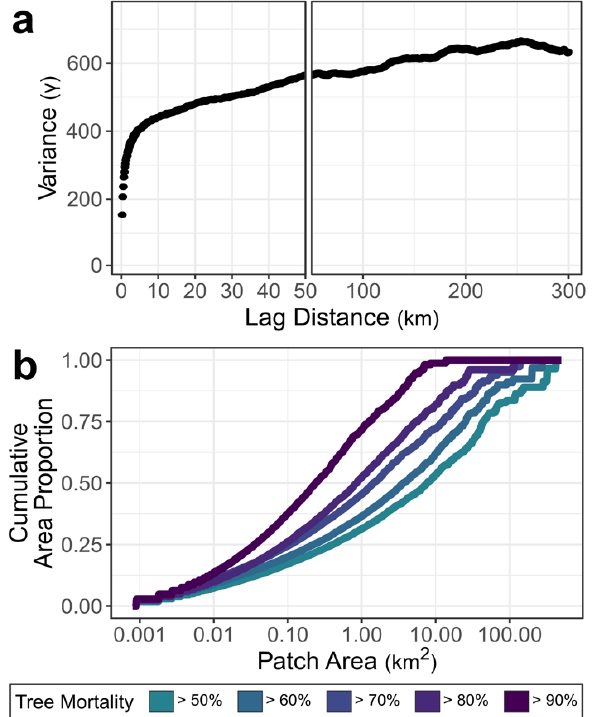
Figure 5. Spatial patterns of bark beetle-caused tree mortality in the Southern Rocky Mountains, USA. ( a ) Sample variogram shows the relationship of tree mortality (i.e., percent basal area loss) among sites at distances from 0 to 300 km, where higher values on the y-axis indicate greater dissimilarity among sites at a given distance. Note that the x-axis in ( a ) is broken with different scales for greater interpretability from 0 to 50 km. ( b ) The cumulative patch-size distribution gives the proportion of the total area exceeding different mortality thresholds contained within patches of different sizes. In ( b ), a convex line shape indicates that the majority of the area is contained within small patches (e.g., ≥ 90% basal area loss), while a concave shape indicates that large patches are more common (e.g., ≥ 50% basal area